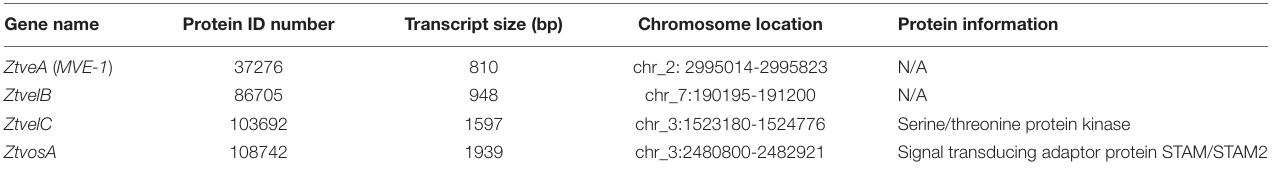
FIGURE 1 | (A) Zymoseptoria tritici IPO323 vegetative growth on PDA, YPDA, and CDV8 agar at 20 ◦ C, under LD or DD conditions, at 10 days post-inoculation (dpi). Cultures grown under LD develop as yeast-like cells which start to melanise after 7–10 dpi Under DD conditions, the Z. tritici cultures melanise and form grey and white aerial hyphae. (B) Neighbour-joining phylogenetic trees of A. nidulans velvet proteins and their relatedness to potential Z. tritici homologues. Bar represents 0.5 amino acid substitutions per site. Blue boxes indicate the candidate orthologues identified in Z. tritici. The previously described Z. tritici MVE-1 protein (Choi and Goodwin, 2011) was identified as a close relative to the A. nidulans VeA protein. Z. tritici protein ID numbers 103692, 86705, and 108742 were identified as potential homologues for the A. nidulans VelC, VelB, and VosA proteins, respectively. (C) Clustal Omega alignment of velB protein sequences from Z. tritici (ZT), A. nidulans (AN), M. oryzae (MO), B. cinerea (Bc), and V. mali (Vm). The characteristic velvet superfamily domains are highlighted in yellow, asterisks identify identical residues, colons identify conserved residues and periods identify semi-conserved residues. TABLE 1 | The four velvet genes chosen for knock-out in Zymoseptoria tritici , listing each gene name, the protein ID number, transcript size, chromosome location, and protein information as annotated in the Z. tritici genome database (Goodwin et al.,